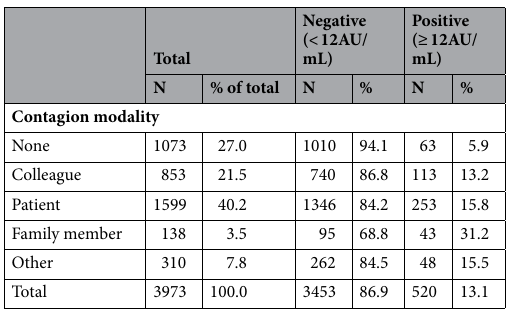
Table 4. Association of interactions with COVID-19 positive people and IgG positivity.